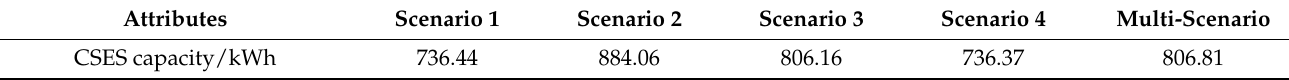
Table 9. Simulation results in different scenario